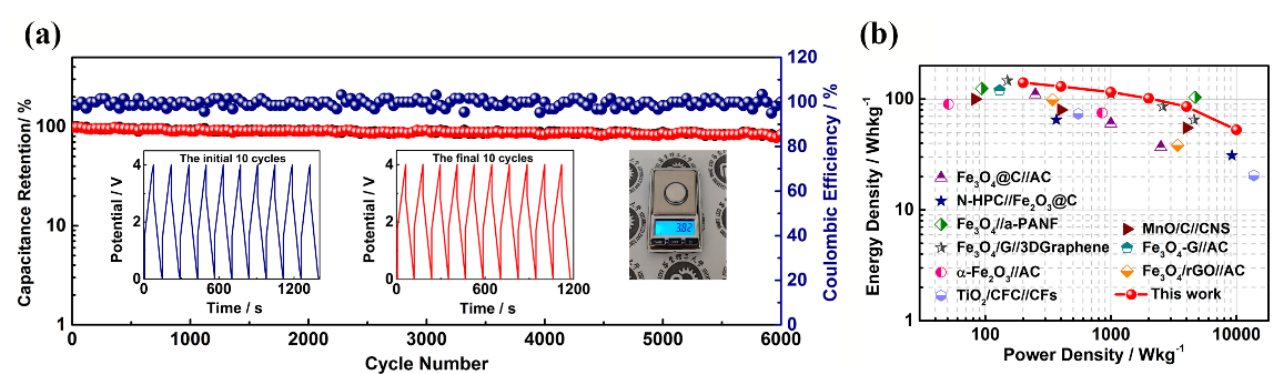
Figure 8. ( a ) Long-term cycling performance and CE of Fe 3 O 4 @C//AC LIC at 2 A g -1 . Inset: GCD profiles of the initial 10 cycles (blue) and the final 10 cycles (red) and the optical photograph showing the microscale worked by our LIC device; ( b ) Ragone plots of LIC in our work and other previously reported LICs.